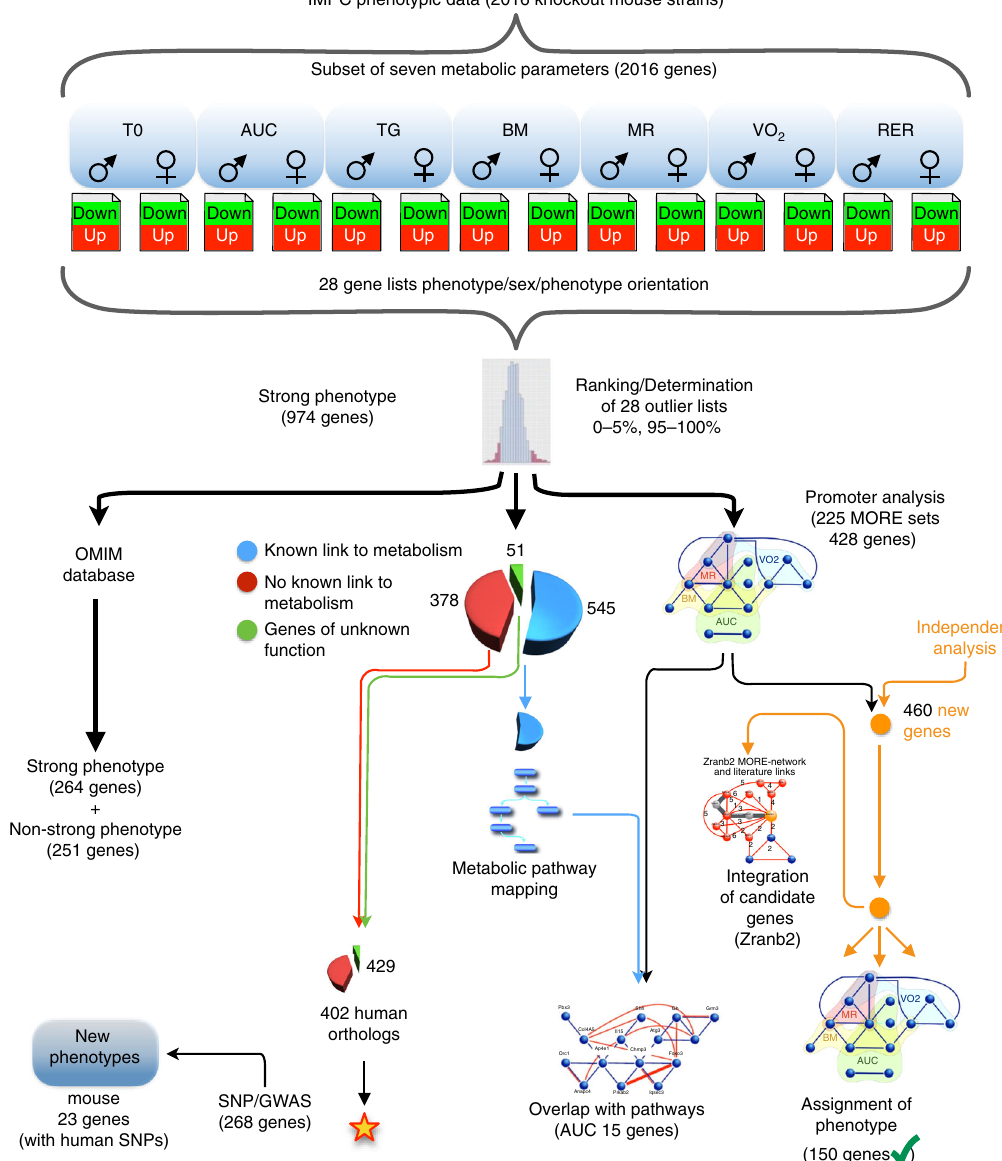
Fig. 1 Strategical abstract depicting the research strategy to identify new genetic elements in metabolism. The IMPC phenotyping data of 2016 knockout mouse strains was systematically evaluated for new links to human metabolic disorders. Nine hundred seventy-four knockout strains showed a strong metabolic phenotype. This set of genes was used as data mining resource. In a multiple line of evidence approach, we fi nally identi fi ed 23 genes that were linked to human disease-related